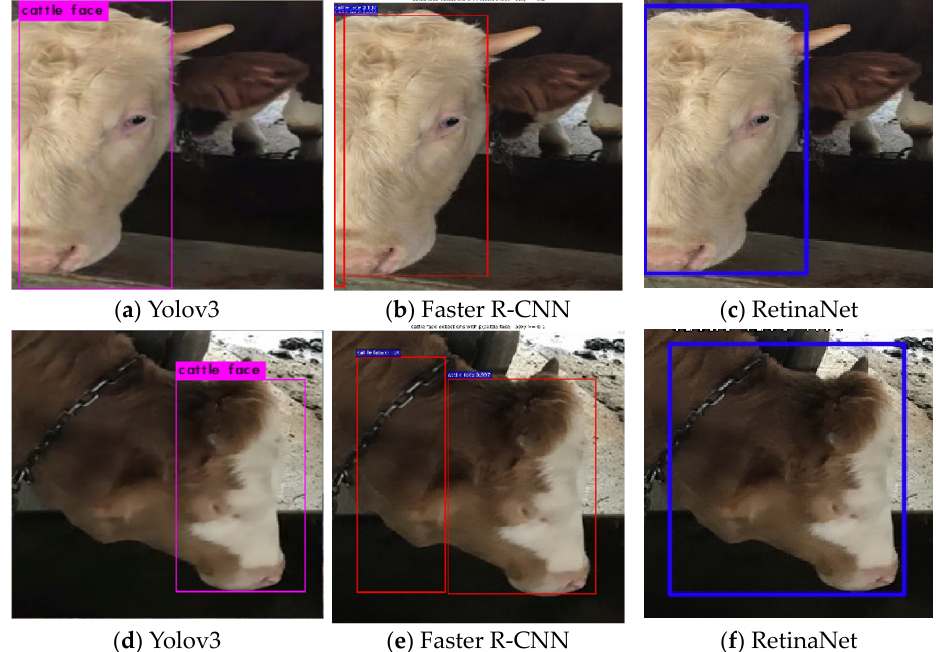
Figure 7. Comparisons of cattle face detection processed by three object detection algorithms in partial occlusion and posture change